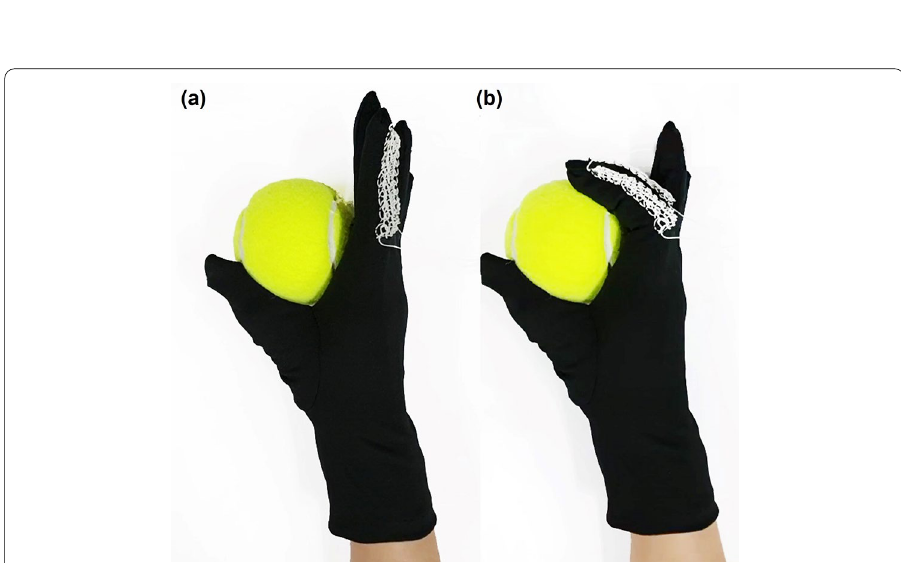
Fig. 9 Before and after actuating with a gripping aid on the hand of an elderly woman. ( a ) before actuation and ( b ) after